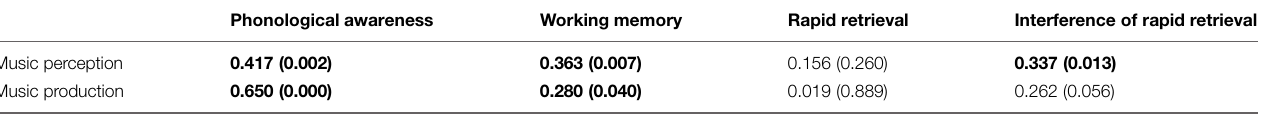
TABLE 2 | Correlations between precursors of reading and music production (total) and music perception